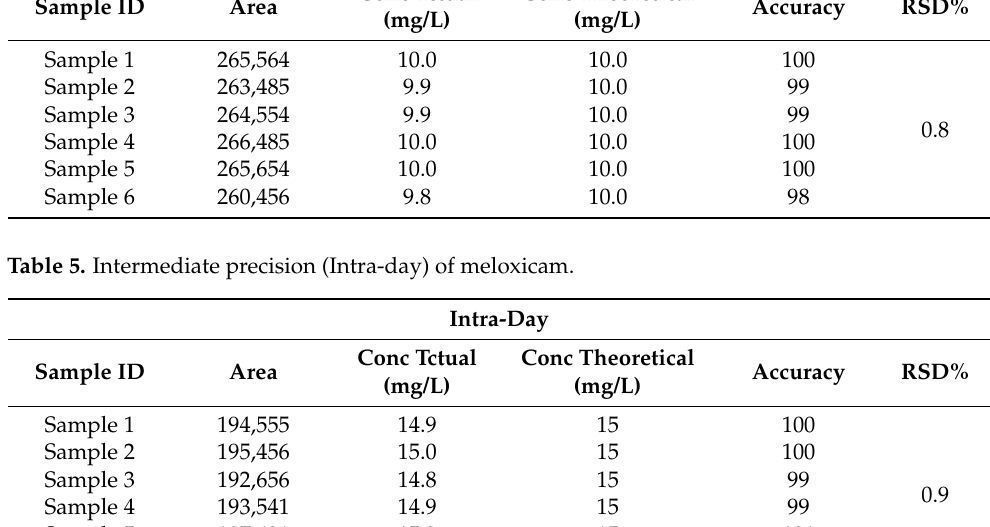
Figure 5. The resolution pattern of meloxicam and pantoprazole mixture. Figure 5 . The resolution pattern of meloxicam and pantoprazole mixture .